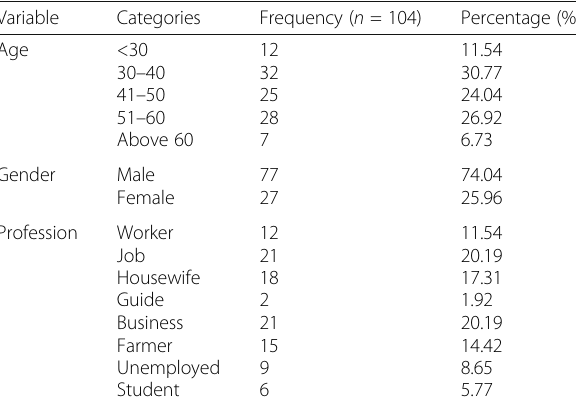
Table 1 Demographic data of the informants. The percentage of people using medicinal plants was highest (30.77%) for the age group 30 – 40 and the percentage of people aged above 60 was the least (6.73%). In addition, considering the profession, students (5.77%) and guides (1.92%) used the least amount of herbal medicine, while local businessmen and job holders used the highest amount (both 20.19%) of medicinal plants to treat different diseases and illness